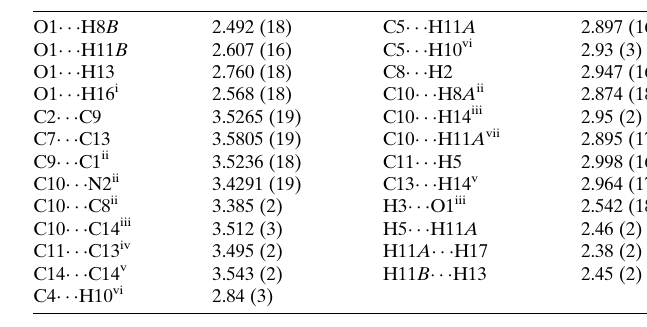
Table 2 Selected interatomic distances (A˚ ).